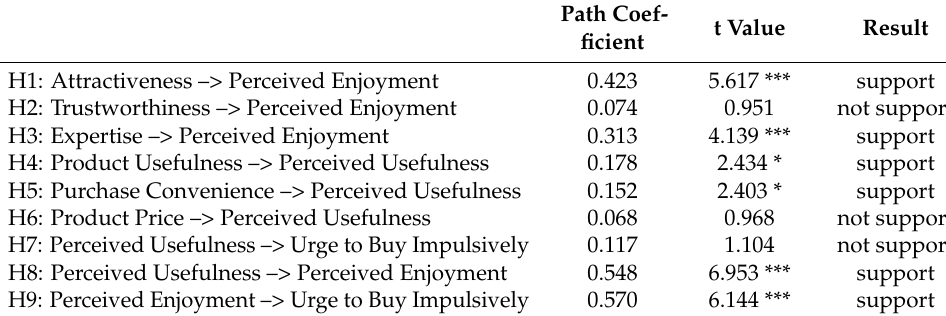
Table 4. Test of hypothesized relationships.